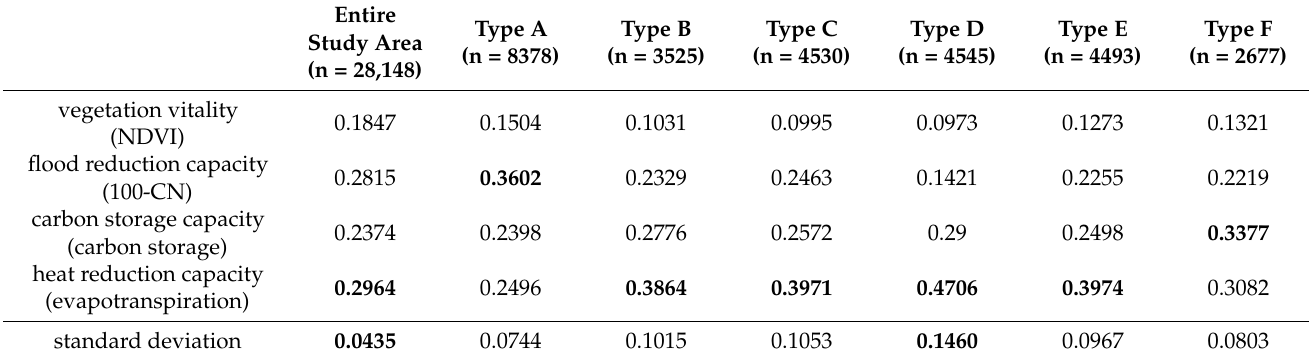
Table 5. Results of pairwise comparison analysis of ERS (eigenvector values).